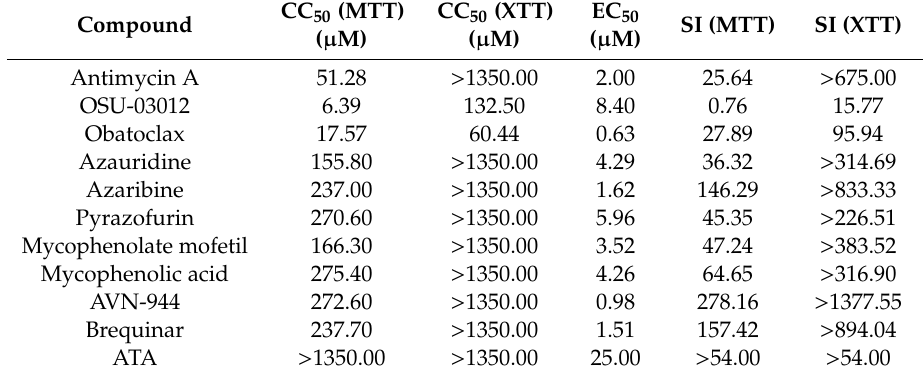
Table 1. CC 50 , EC 50 and SI of the compounds on ZIKV Paraiba / 2015 replication (post-infection). CC 50 (MTT) CC 50 (XTT) EC 50 SI (MTT) SI (XTT) Compound ( µ M) ( µ M) ( µ M) Antimycin A 51.28 > 1350.00 2.00 25.64 > 675.00 OSU-03012 6.39 132.50 8.40 0.76 15.77 Obatoclax 17.57 95.94 Azauridine 155.80 Azaribine 237.00 > 1350.00 146.29 > 833.33 Pyrazofurin 270.60 45.35 Mycophenolate mofetil 166.30 > 1350.00 > 383.52 Mycophenolic acid 275.40 272.60 Brequinar 237.70 ATA